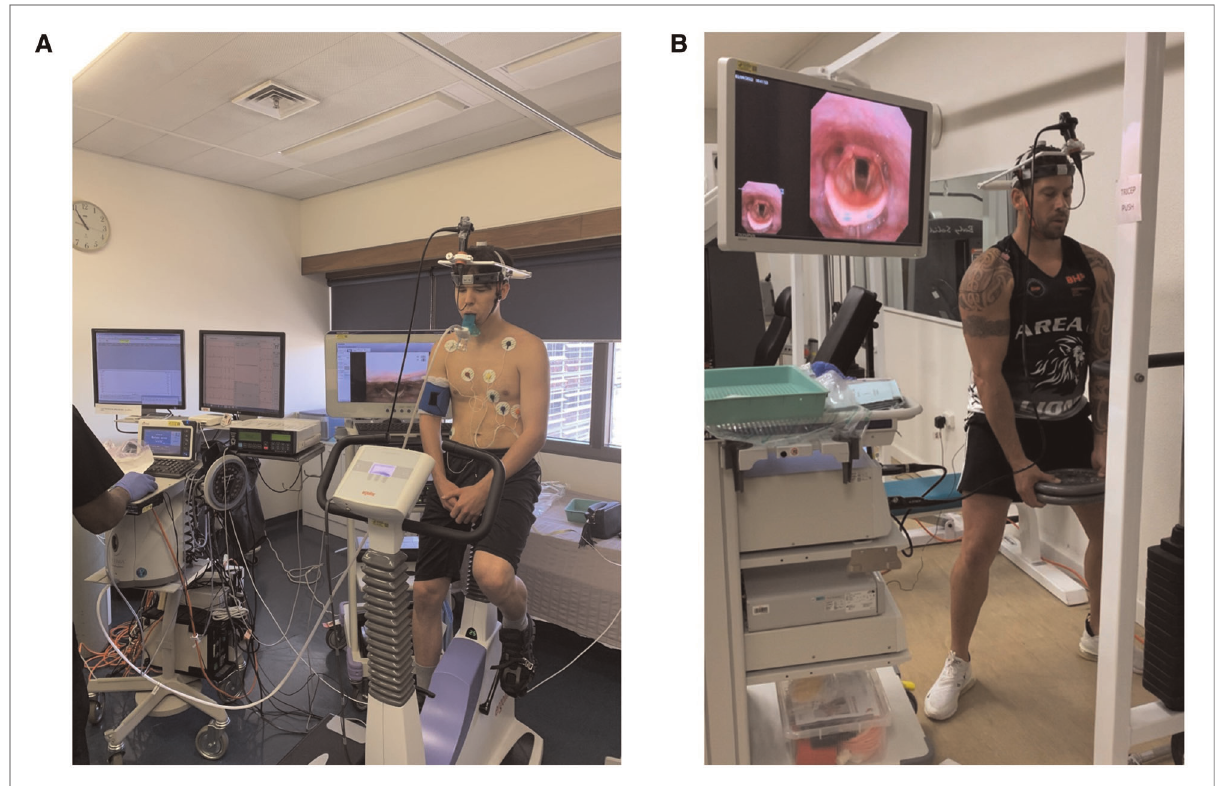
FIGURE 3 ( A ) patient prior to undergoing direct laryngoscopy with cardiopulmonary exercise testing. ( B ) Demonstrates a patient undergoing CLE whilst weightlifting. Both images are reproduced with the patients ’ consent.